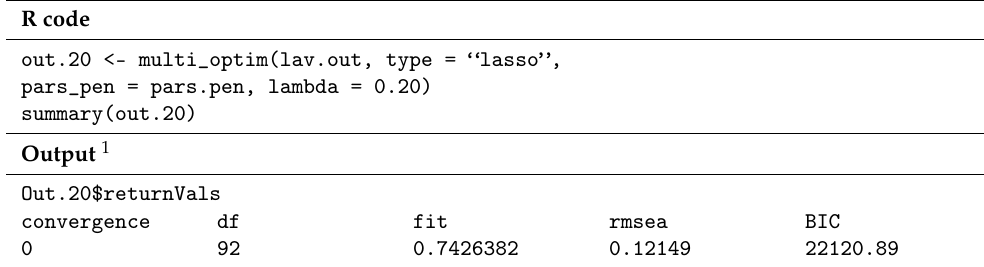
Table 5. R code and output for using multi_optim() function for non-convergence cases. R